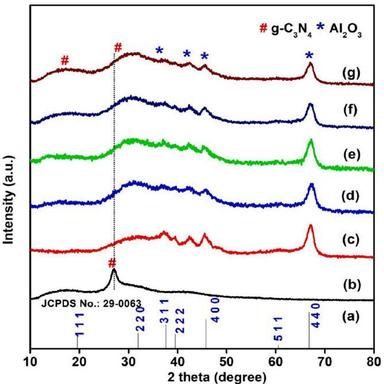
X-ray diffraction patterns of g-C3N4, CN-A and Al2O3 samples with various loadings: (b) g-C3N4; (c) Al2O3; (d) 4.7CN-A; (e) 9CN-A; (f) 13CN-A; (g) 16CN-A.